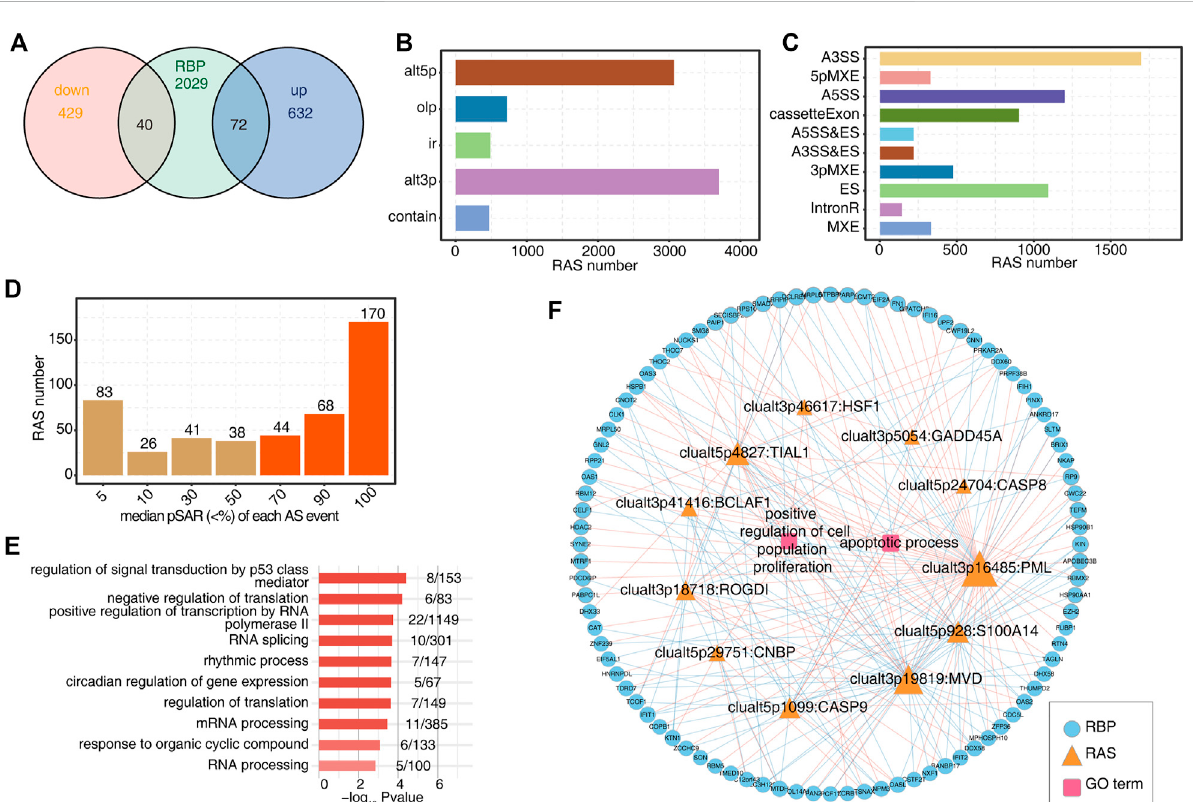
FIGURE 4 TP53TG1 regulates the alternative splicing of genes associated with proliferation and apoptosis and the expression of a large number of RBP genes. (A) VenndiagramshowingthenumberofDEGsregulatedbyTP53TG1andRNA-bindingproteins. (B) BarplotshowsthenumberofRASevents detected by SUVA between TP53TG1-OE and control samples. (C) Splice junction constituting TP53TG-regulated RAS events was annotated as classical ASevent types. Andthenumber ofeachclassical ASevent typewasshown inthebarplot. (D) Barplotshowing TP53TG-regulated RAS events with different pSAR. RAS events whose pSAR (Reads proportion of SUVA AS event) ≥ 50% were labeled in orange and were used for further analysis. (E) GOenrichmentanalysisofthebiologicalprocessesofgeneswithTP53TG-regulatedRASevents(RASG)whosepSASR ≥ 50%. (F) Theco- disturbednetworkamongexpressionofDERBPsandsplicingratiosofRASevents(pSAR ≥ 50%)whichlocatedonproliferationandapoptosis-related genes was constructed. |Pearson ’ s correlation| ≥ 0.95 and p -value ≤ 0.01 were retained for RBP and RAS correlation. Circles represent RBP genes. Triangles indicate RAS. Squares in center indicate GO terms. Node size indicates the degree of connection with other